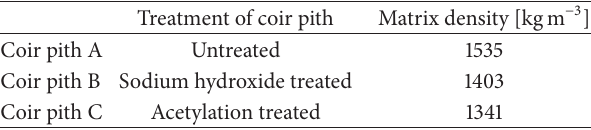
Table 4: Chemical treatment of coir piths.